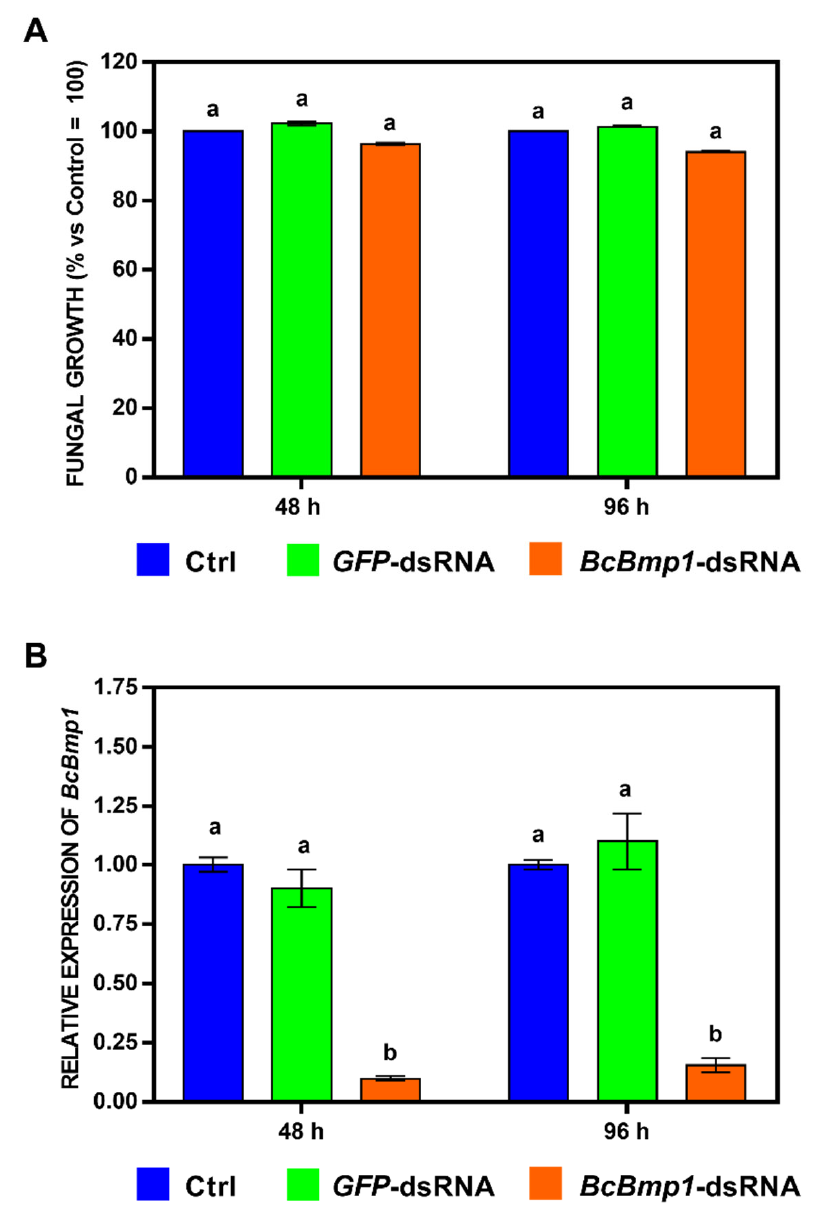
Figure 1. In vitro effects of BcBmp1 -dsRNA on fungal growth and relative expression levels of the target gene BcBmp1 . ( A ) Fungal growth was assessed by measuring the optical density (OD 595 ) at 48 and 96 h in 96-well microtiter plates. In each well, there were aliquots of a conidial suspension of B. cinerea B05.10 (5 × 10 2 spores) in SMB medium and 2 µ g of dsRNA ( GFP -dsRNA (green) or BcBmp1 -dsRNA (orange)). SMB + TE buffer was used as control (Ctrl, blue). The graph shows the mean ( ± SE) of three independent experiments with eight biological replicates ( n = 8). Same letters above the bars indicate no significant differences from each other (ANOVA) according to Tukey’s HSD test ( p ≤ 0.05). ( B ) Expression of BcBmp1 mRNA in mycelium of B. cinerea B05.10 treated with GFP -dsRNA or BcBmp1 -dsRNA at 48 and 96 h. SMB + TE buffer was used as control (Ctrl, blue). Relative transcript values were calculated by qRT-PCR using Ctrl and GFP -dsRNA as reference samples and were normalized to the BctubA gene. The graph shows the mean ( ± SE) of three biological replicates ( n = 3). Same letters above the bars indicate no significant differences from each other (ANOVA) according to Tukey’s HSD test ( p ≤ 0.05). The statistical analysis was conducted separately for 48 and 96 h.